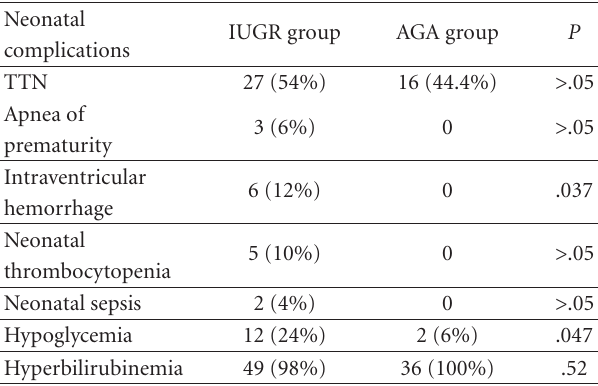
Table 3: Comparison of neonatal complications between the IUGR and AGA